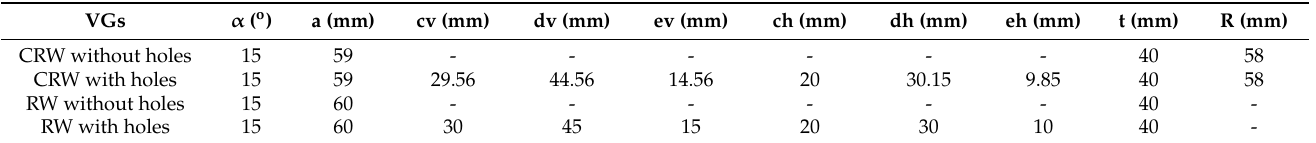
Figure 3. Top view of test plate with ( a ) RWVGs and ( b ) CRWVGs. Table 1. Detail geometry of VG.